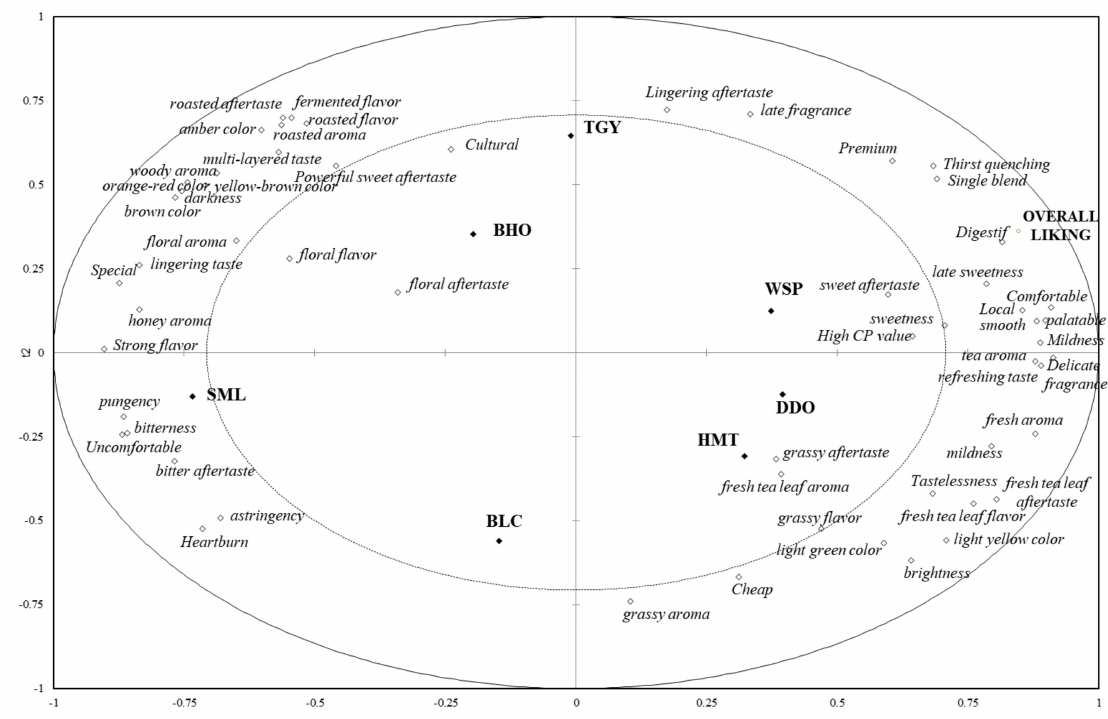
Figure 4. The partial least squares regression (PLSR) correlation loading plot of sensory, association, postprandial perception attributes and overall liking of seven Taiwanese specialty teas. The model was derived from attribute data as the X-matrix and overall liking data as the Y-matrix. The default values for radii correspond to 50% and 100% explained variance, respectively. BLC: Bi-Luo-Chun green tea, WSP: Wenshan Pouchong tea, HMT: High-mountain oolong tea, DDO: Dong Ding oolong tea, TGY: Iron Goddess oolong tea, BHO: Baihao oolong tea, SML: Yuchi Sun-Moon-Lake black tea. “High